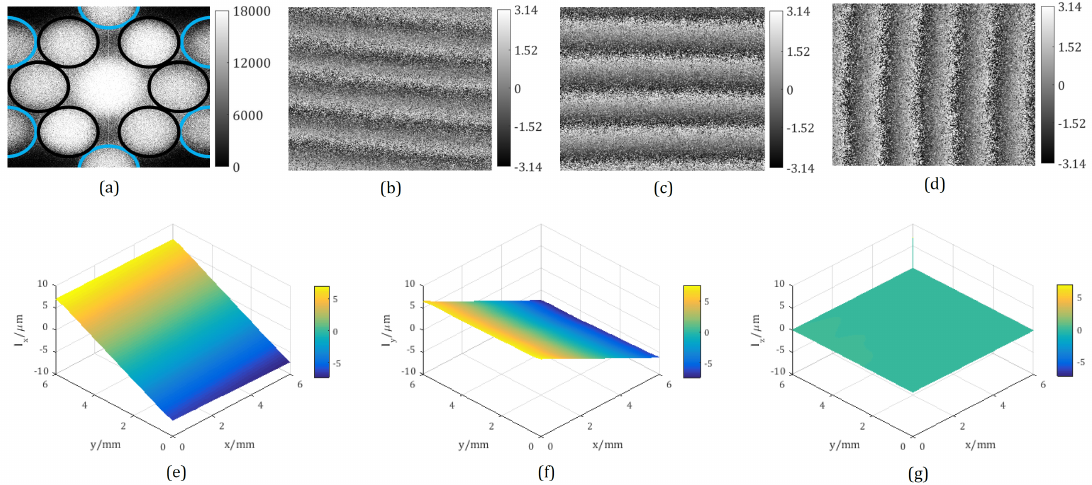
Figure 6. Experimental results of a rigid-body rotation: ( a ) is the spectrum of the recorded speckle interferogram; ( b – d ) are the wrapped phase change maps due to in-plane rotation, i.e., φ 01 , φ 02 and φ 03 in rad; ( e – g ) represent the three components of the object’s displacement, i.e., l x , l y and l z in µ m.